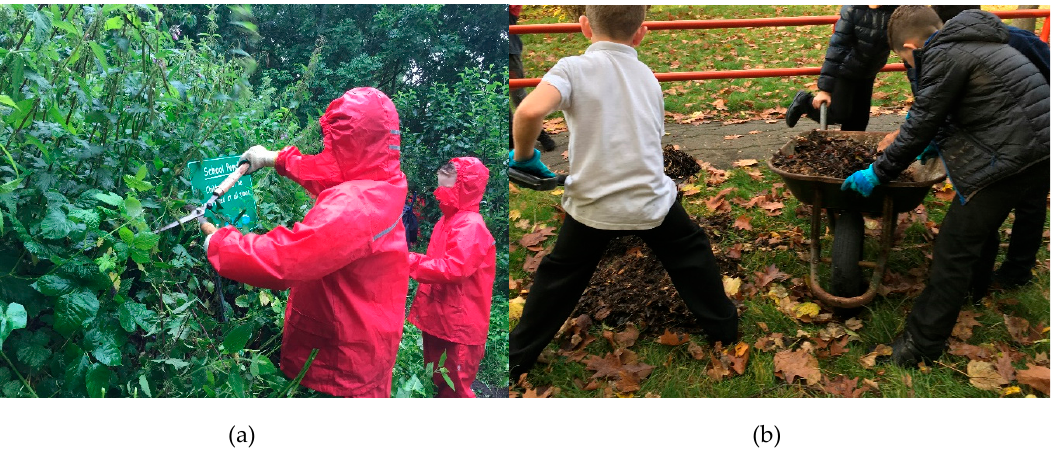
Figure 3. (a) and (b) Some examples of physical activities children were engaged in during